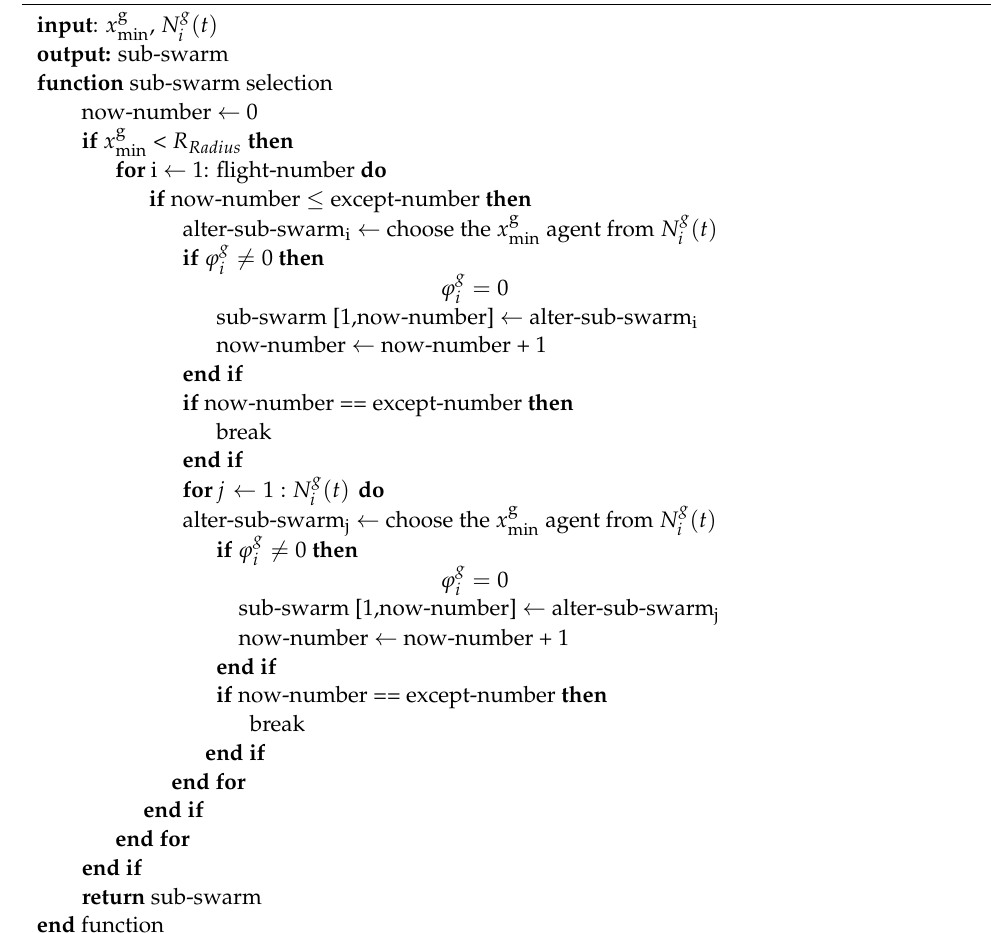
Algorithm 1 Sub-Swarm Selection Algorithm